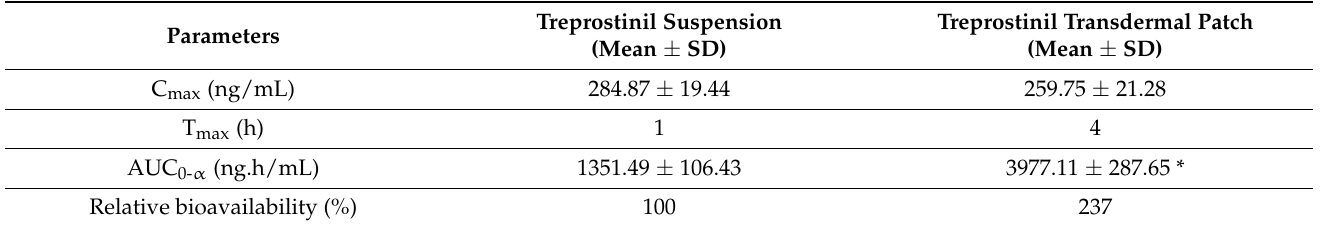
Table S3. ANOVA for Quadratic model for drug release; Table S4. ANOVA for quadratic model for transdermal flux; Table S5. Model fitting for optimized Treprostinil patch; Figure S1. Load versus time curve of the peeling force of optimized patch; Figure S2. Load versus time curve of the tackiness of optimized patch.